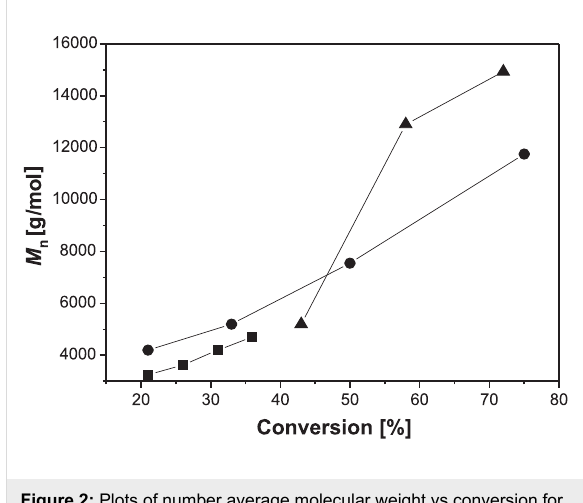
Figure 2: Plots of number average molecular weight vs conversion for the homopolymerization of 2VP for ■ 90 °C, ● 110 °C, ▲ 130 °C, (molar ratio [initiator]/[monomer] 1:140).